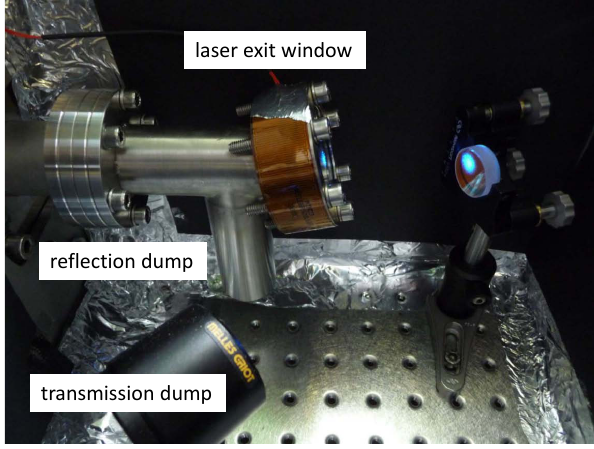
Fig. 2. Home-made laser exit port equipped with anti-reflection window and back-reflection dump. See text for